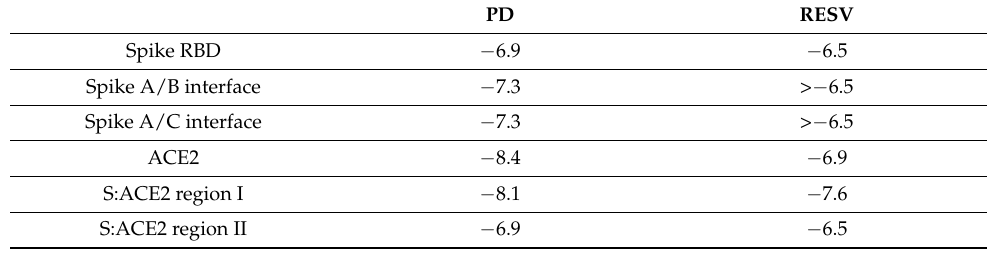
Table 1 for the docking scores of all top-ranked docked poses and Table S2 for the complete outputs of the docking simulations) shows that the PD glucose residue establishes hydrogen bonds interactions with Asn343, Ala344, Asp442 and Trp436 (Figure 2a,b, see also Table S1 for a complete list of residues composing the binding pockets). The stilbene moiety of PD is in turn involved in hydrophobic interactions with the surrounding residues. The glucose residue appears therefore relevant for PD binding capabilities, allowing several interactions through its OH groups. At the same time, the glycosidic bond torsional flexibility contributes to better fit the exposed RBD pockets. Table 1. Docking scores (i.e., the approximate binding energy estimated by the docking scoring function, kcal/mol units) for PD and RESV top-ranked docked poses.